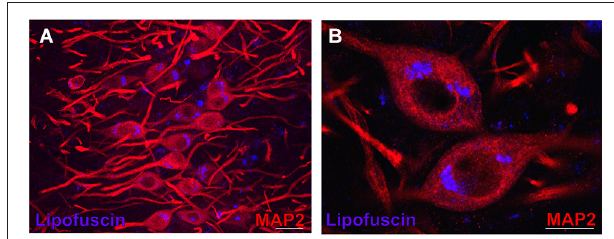
FIGURE 3 | Lipofuscin granules in medial superior olive (MSO) neurons of an aged gerbil . MSO neurons are MAP2 immunostained (Alexa Fluor 647, red). Lipofuscin granules have been excited with the DAPI excitation wavelengths and appear blue. Confocal images show a maximum projection of image stacks in (A) and a single optical image of 0.3 µ m thickness in the enlargement in (B) . Scale bar in (A) : 50 µ m and 20 µ m in (B)